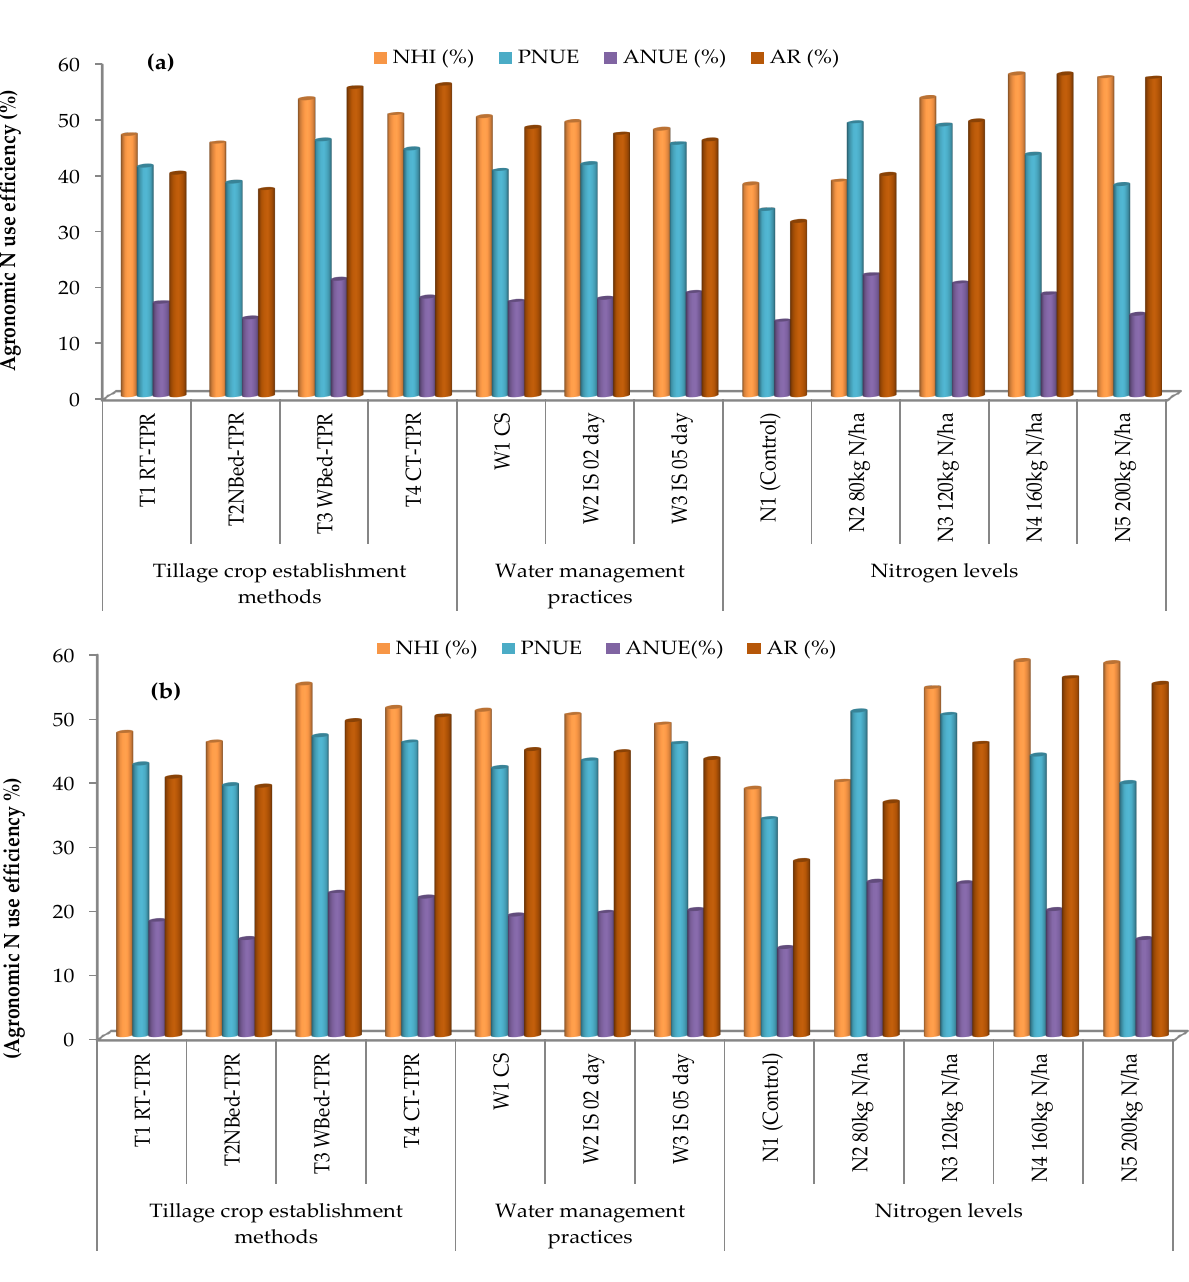
Figure 3. Tillage, water and nitrogen interactive effects on nitrogen use efficiency parameters in both years: ( a ) 2016 and ( b ) 2017.